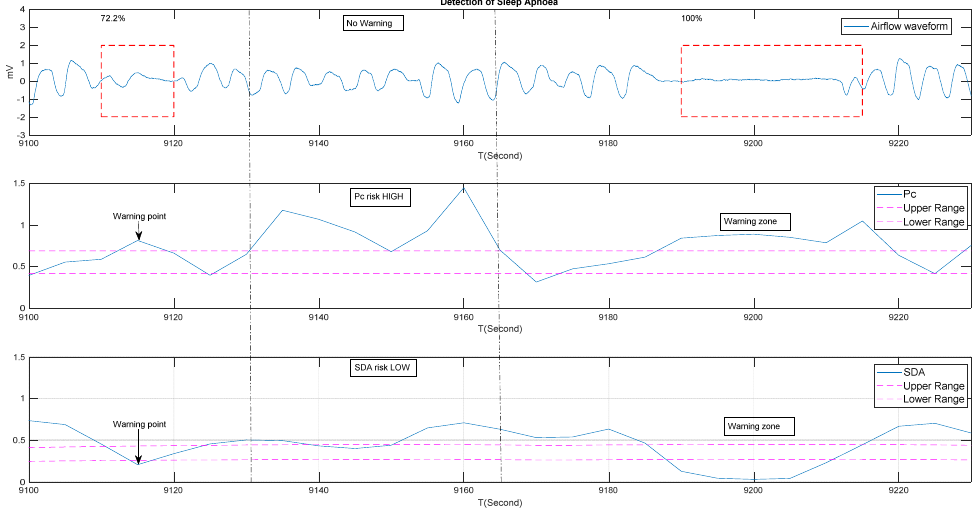
Figure 3. Standard example of fusion results.